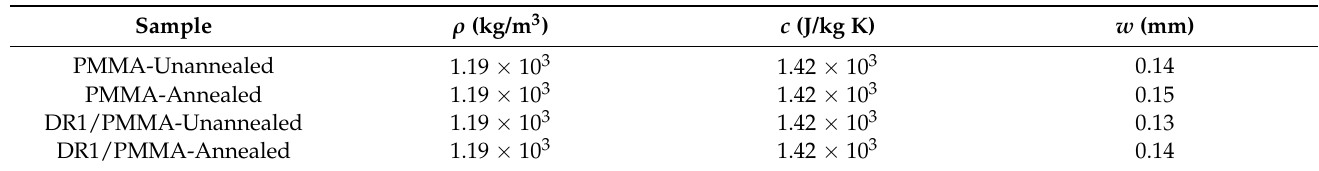
Figure 18. The photothermal heating contribution to the photomechanical response as a function of the static absorbed intensity I 0 derived using Equation (7). The “marked” fibers are painted with black marker ink. The inset shows the contribution of each fiber averaged over all intensities. Table 4. Density ρ , the specific heat c , and thickness w of the fibers used in the models in this paper are from the literature [23,41].